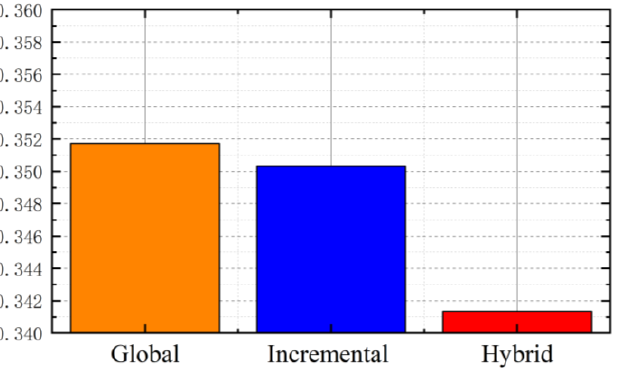
Figure 12. RMSE value of sparse model.